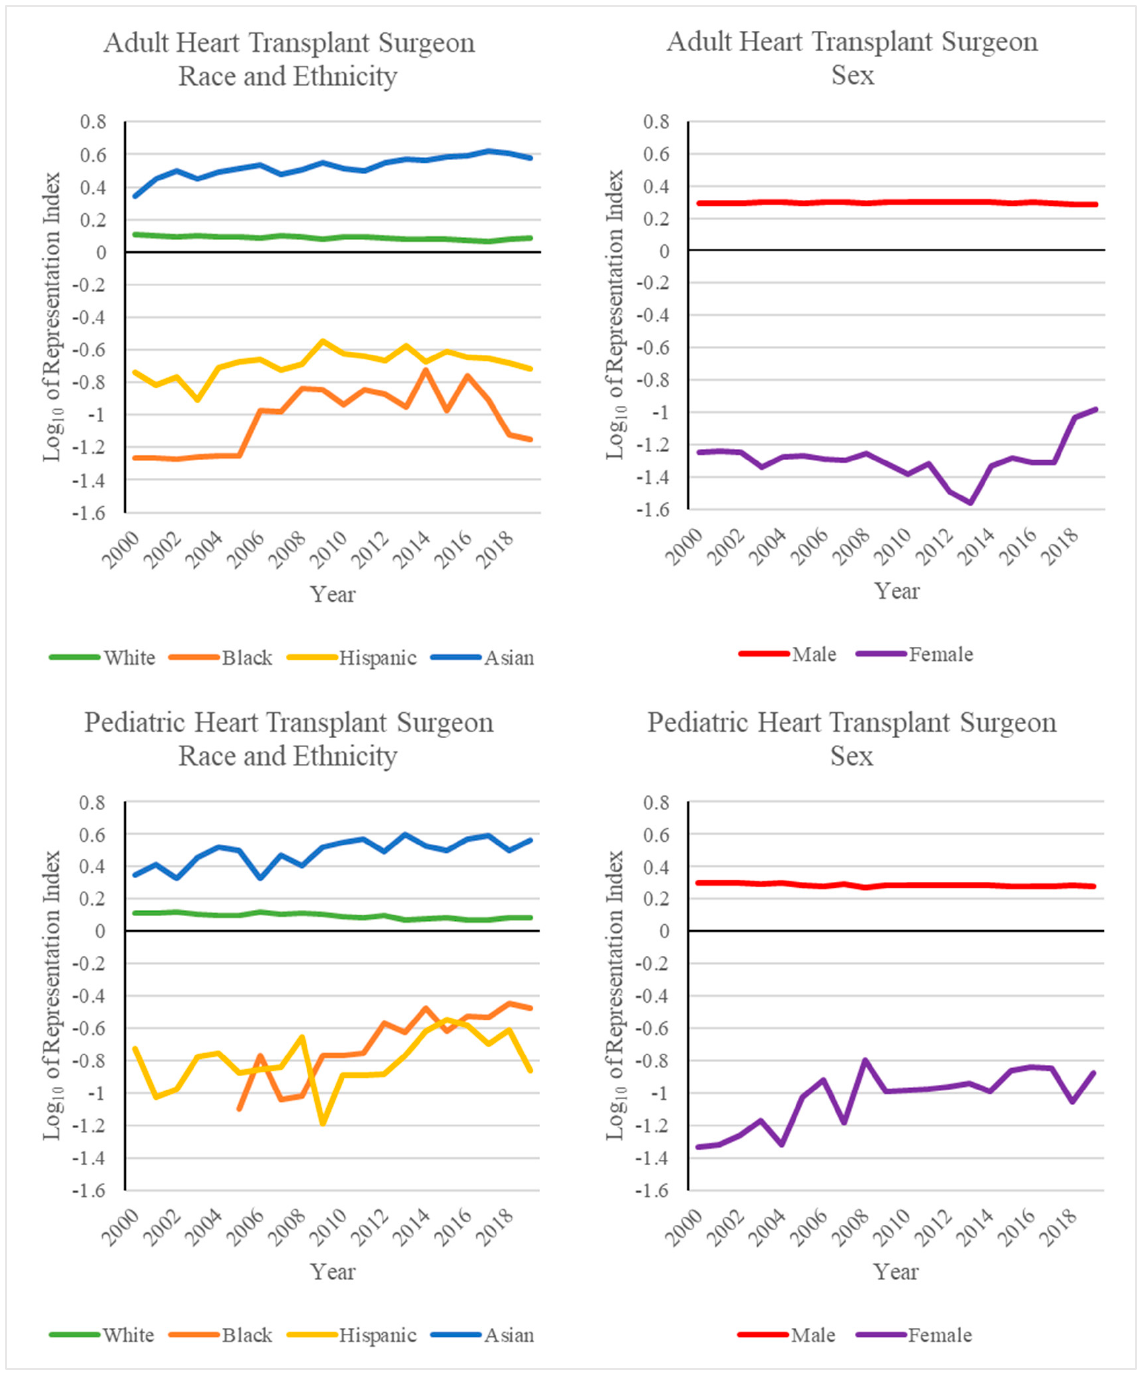
Figure 2. Common logarithm of the representation index by year of surgeons performing at least one HTx. Values greater than zero indicate overrepresentation, and values less than zero indicate underrepresentation. The representation index was calculated with respect to US Census data